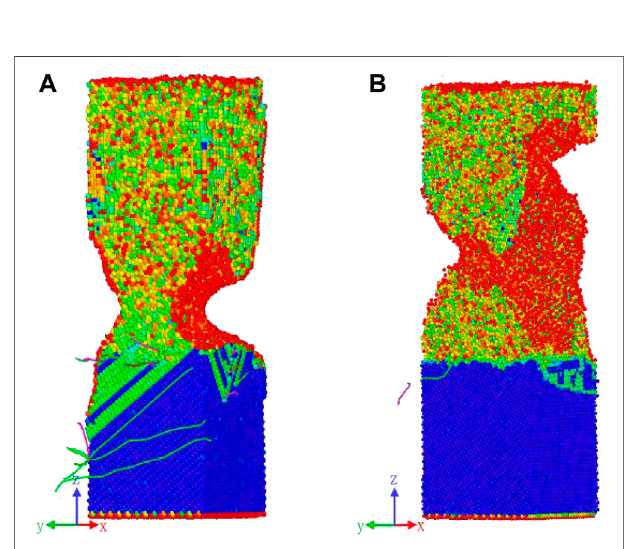
FIGURE 4 | CSP and DXA results of the single-crystal Cu/Cu 3 Sn interface at strain rates of (A) 0.01% ps − 1 and (B) 0.1% ps − 1 .